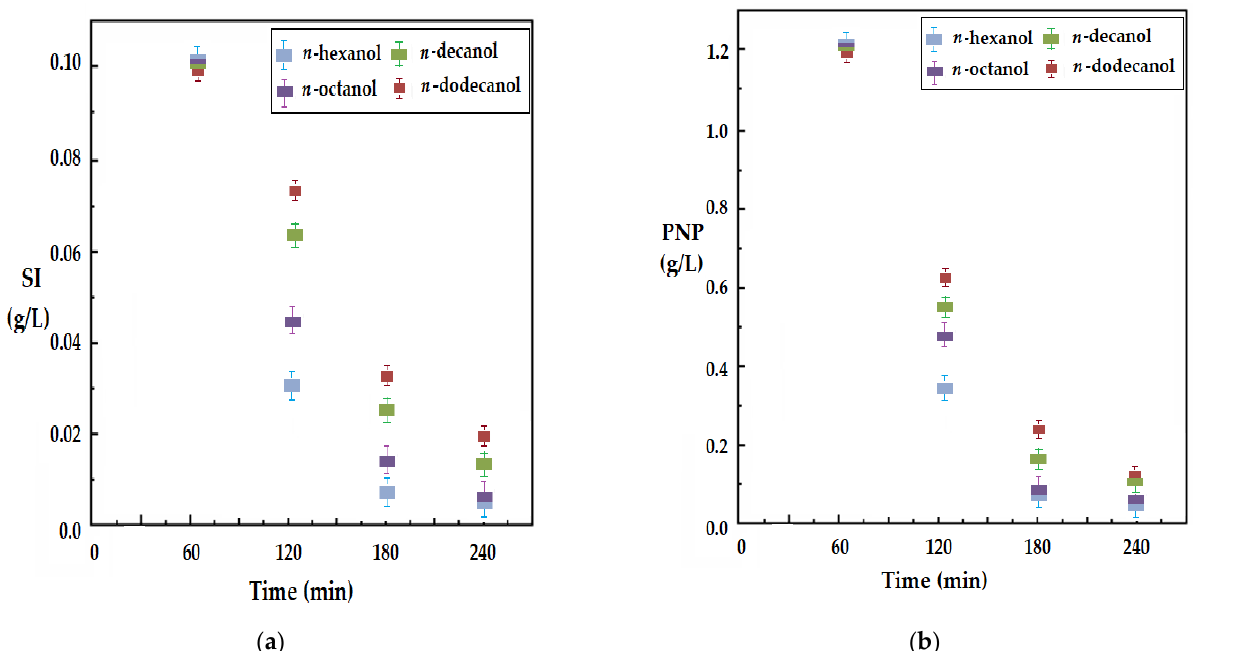
Figure 11. The decrease in the concentration, depending on time, of silver ions (SI) and p -nitrophenol (PNP) in the source phase through a membrane of n -alkyl alcohols with 6, 8, 10 and 12 carbon atoms, with a 10–undecenoic acid transporter (UDAc) and pH = 7 in the source phase, at the pH of the receiving phase: ( a ) pH = 1, for SI; ( b ) pH = 13, for PNP.